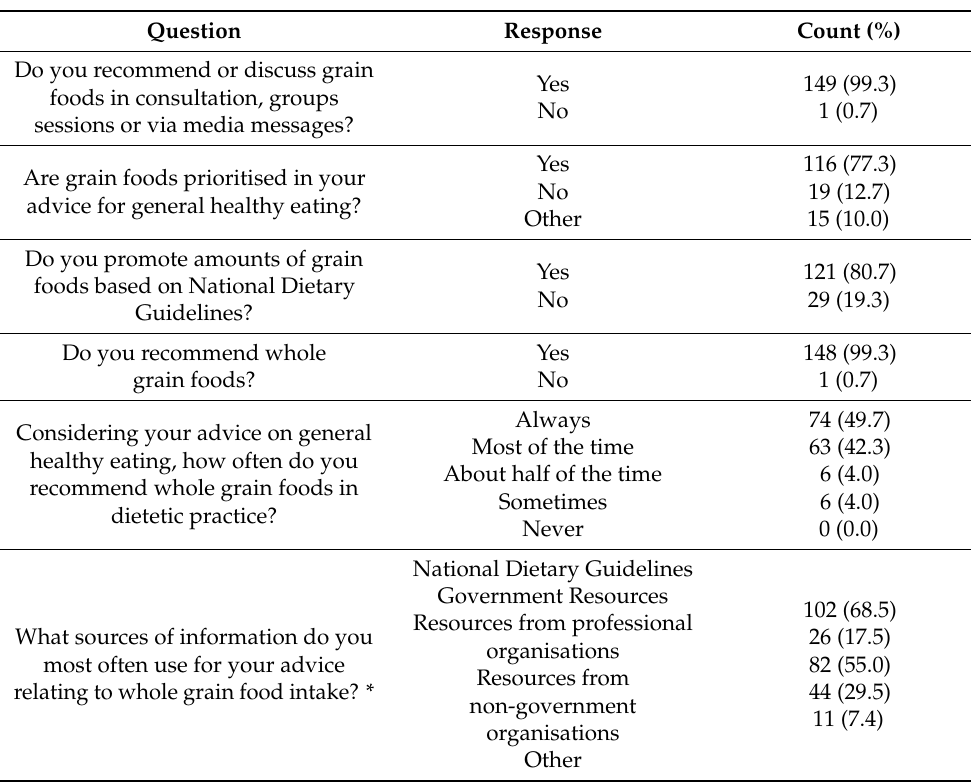
Table 2. Dietitian recommendations, sources and frequency of advice related to grains and whole